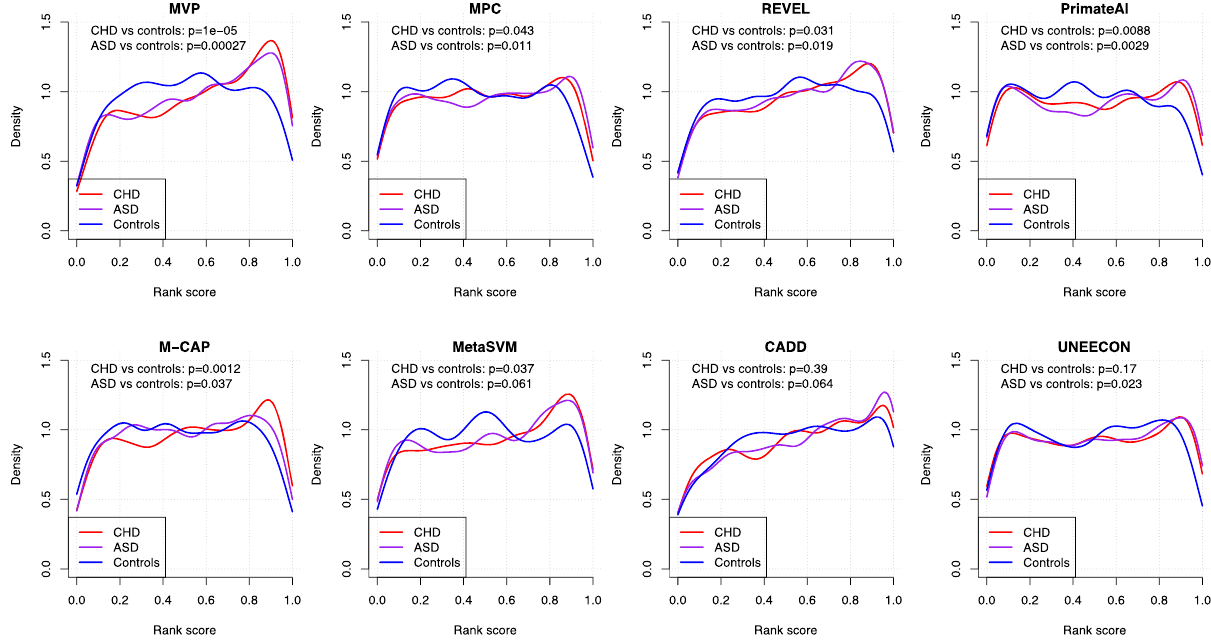
Fig. 3 Distribution of predicted scores of de novo missense variants by MVP and other methods. For each method, we normalized all predictions by rank percentile, and used two-sided Mann – Whitney U test to assess the statistical signi fi cance of the difference between cases and controls. CHD: congenital heart disease; ASD: autism spectrum disorder; controls: unaffected siblings from the ASD study. Number of de novo missense variants compared: CHD: 1486; ASD: 2050; controls: